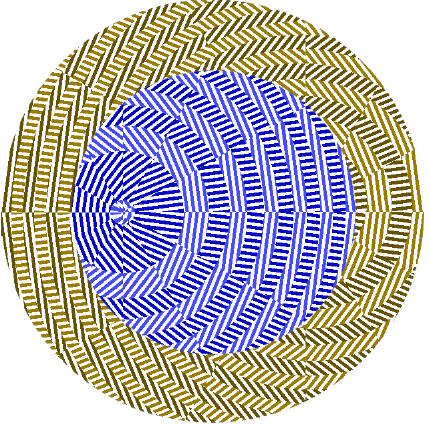
Figure 1. Metalens for detecting an LHCP laser beam with TC m = − 1 and m = − 2: white is a metalens material, colored patterns—through grooves. Blue/cyan colors correspond to the inner metalens intended to focus a beam with TC m = − 1 at point ( − 3 μ m; 0), brown/yellow—for the outer one for a beam with m = − 2 and a focal point at (3 μ m; 0). In the gratings, the darker-colored zones (blue, brown) are rotated by 90 degrees relative to the lighter-colored zones (yellow, cyan) as the corresponding phases in these zones are shifted by π , thus making it possible to focus the incident light. These zones are circular in the inner metalens (cyan/blue areas are round) and spiral in the outer one (brown/yellow). Each zone is divided into 12 sectors, with the direction of gratings in each sector being constant.